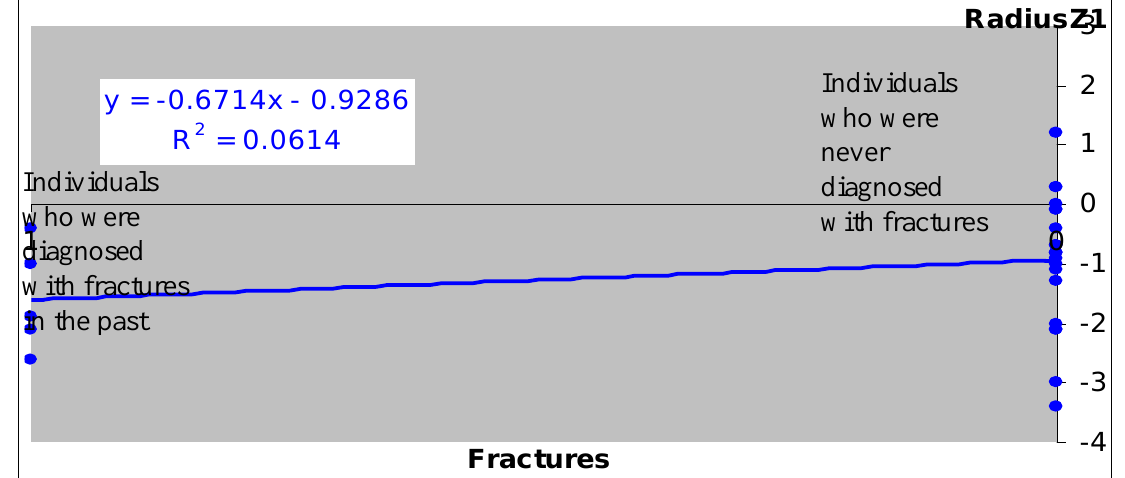
FIGURE 5 . The connection between fractures and bone